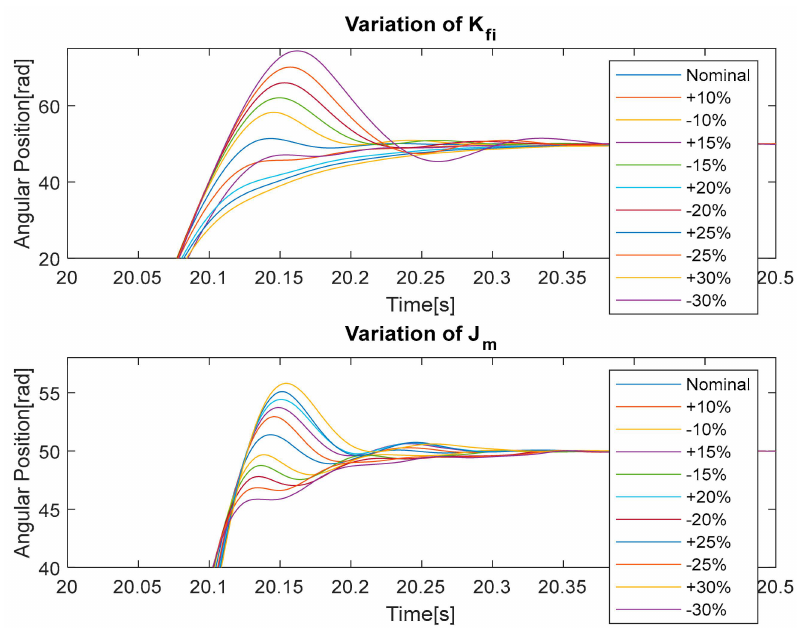
Figure 13. Robustness analysis in terms of variation of the parameters k ϕ and J m